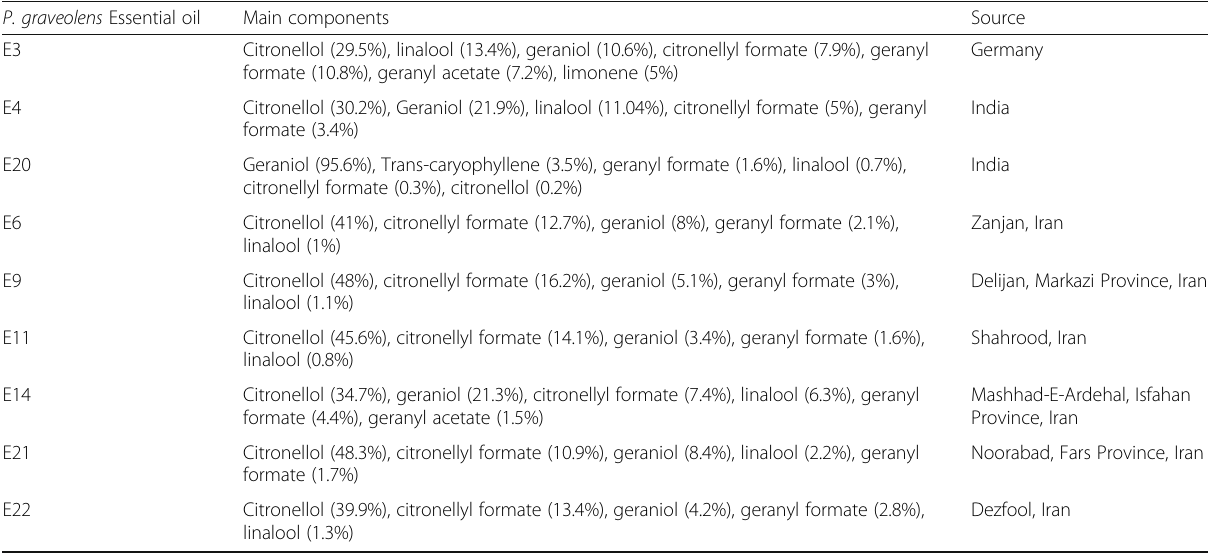
Table 1 The chemical composition of P. graveolens essential